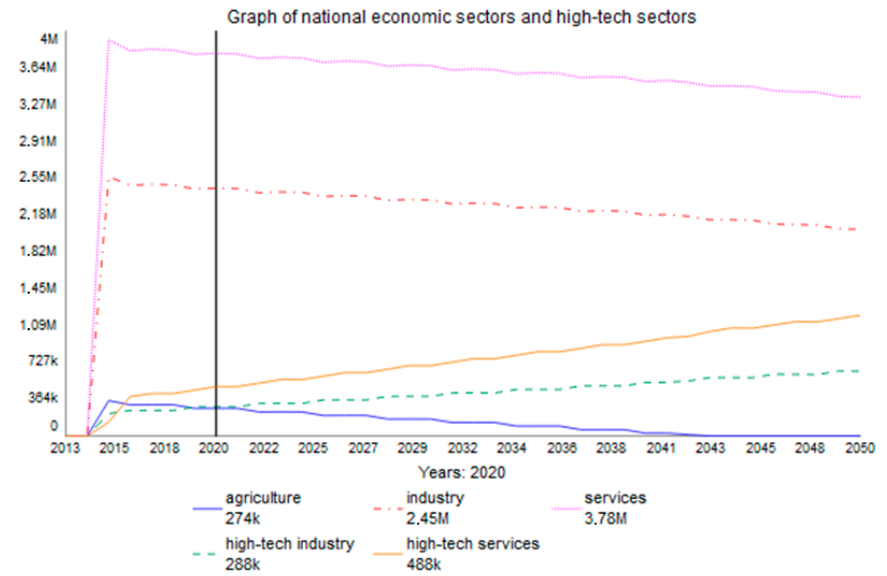
Figure 2. National economic sectors and high-tech sectors (year 2020).